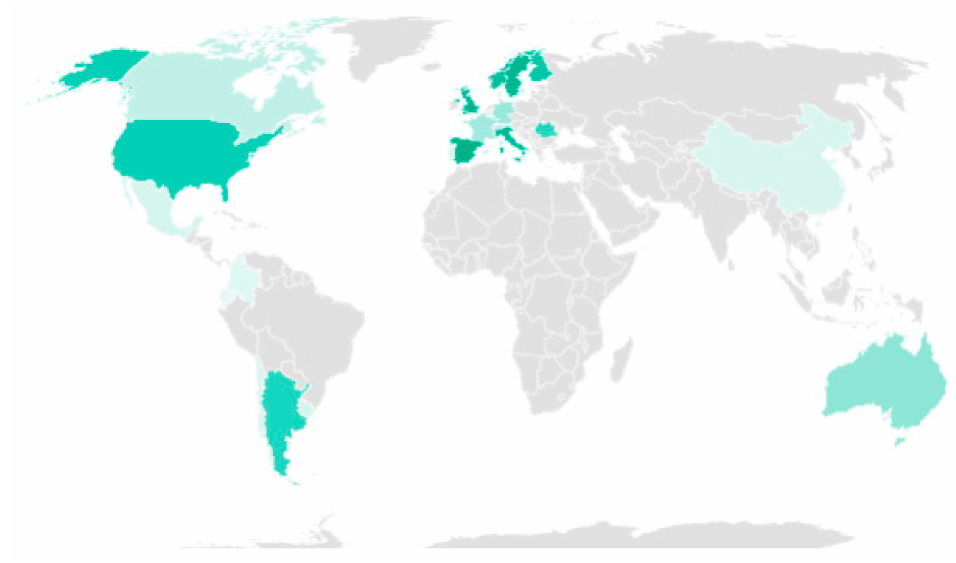
Figure 2. Choropleth map of frequency of reviews per country. Source: Own elaboration from TripAdvisor